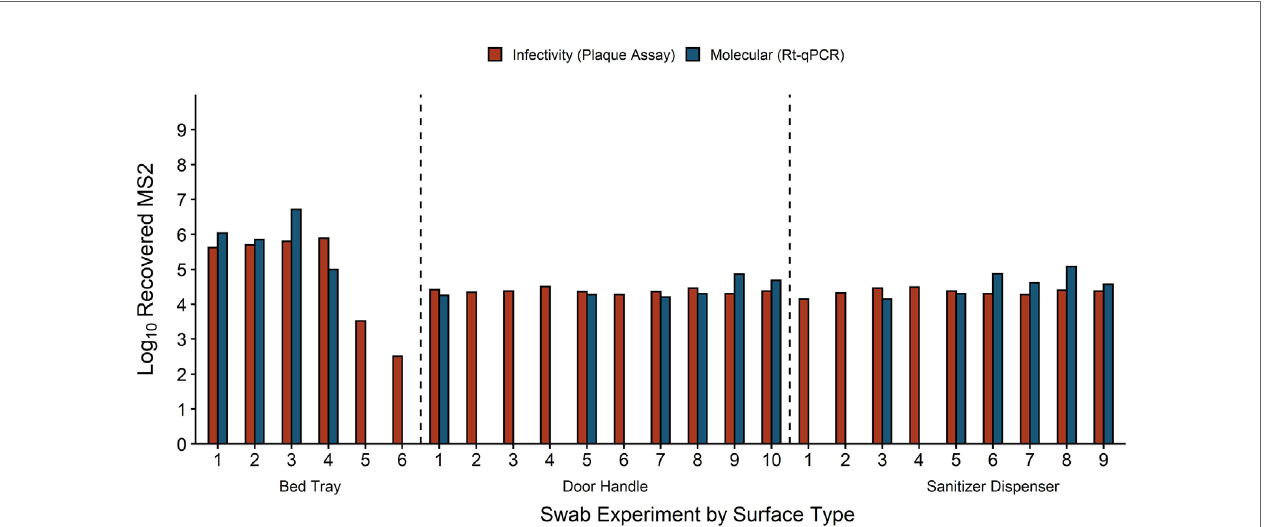
FIGURE 6 | Recovery of MS2 by infectivity and molecular methods for each individual swab experiment. MS2 recovery is equivalent to plaque forming units for infectivity and genome equivalents (GE) for molecular. Fomites were inoculated with 50 m l HuNoV stool suspension mixed with 10 2 – 10 7 MS2 GE/3 cm 2 . Fomites were swabbed with macrofoam swabs pre-moistened in phosphate buffered saline plus 0.02% Tween80. Swab eluate was tested for MS2 replication with an E. coli plaque assay and for MS2 molecular recovery using